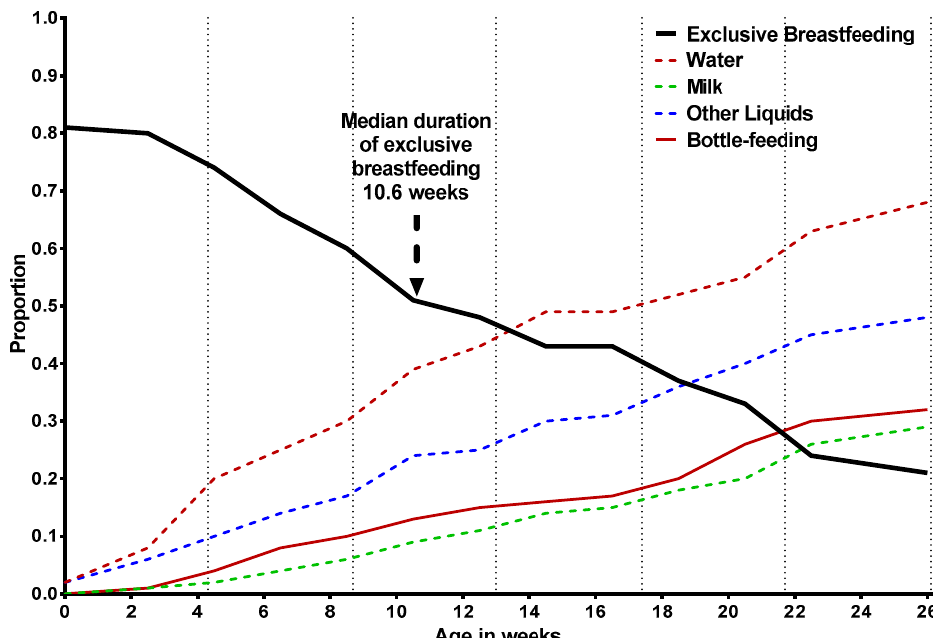
Figure 2. Age-smoothed proportion of exclusively breastfed infants aged under six months. The figure also presents age- smoothed proportions of bottle feeding and the consumption of water, milk and other liquids (other than water, milk, juice, broth, runny porridge, or